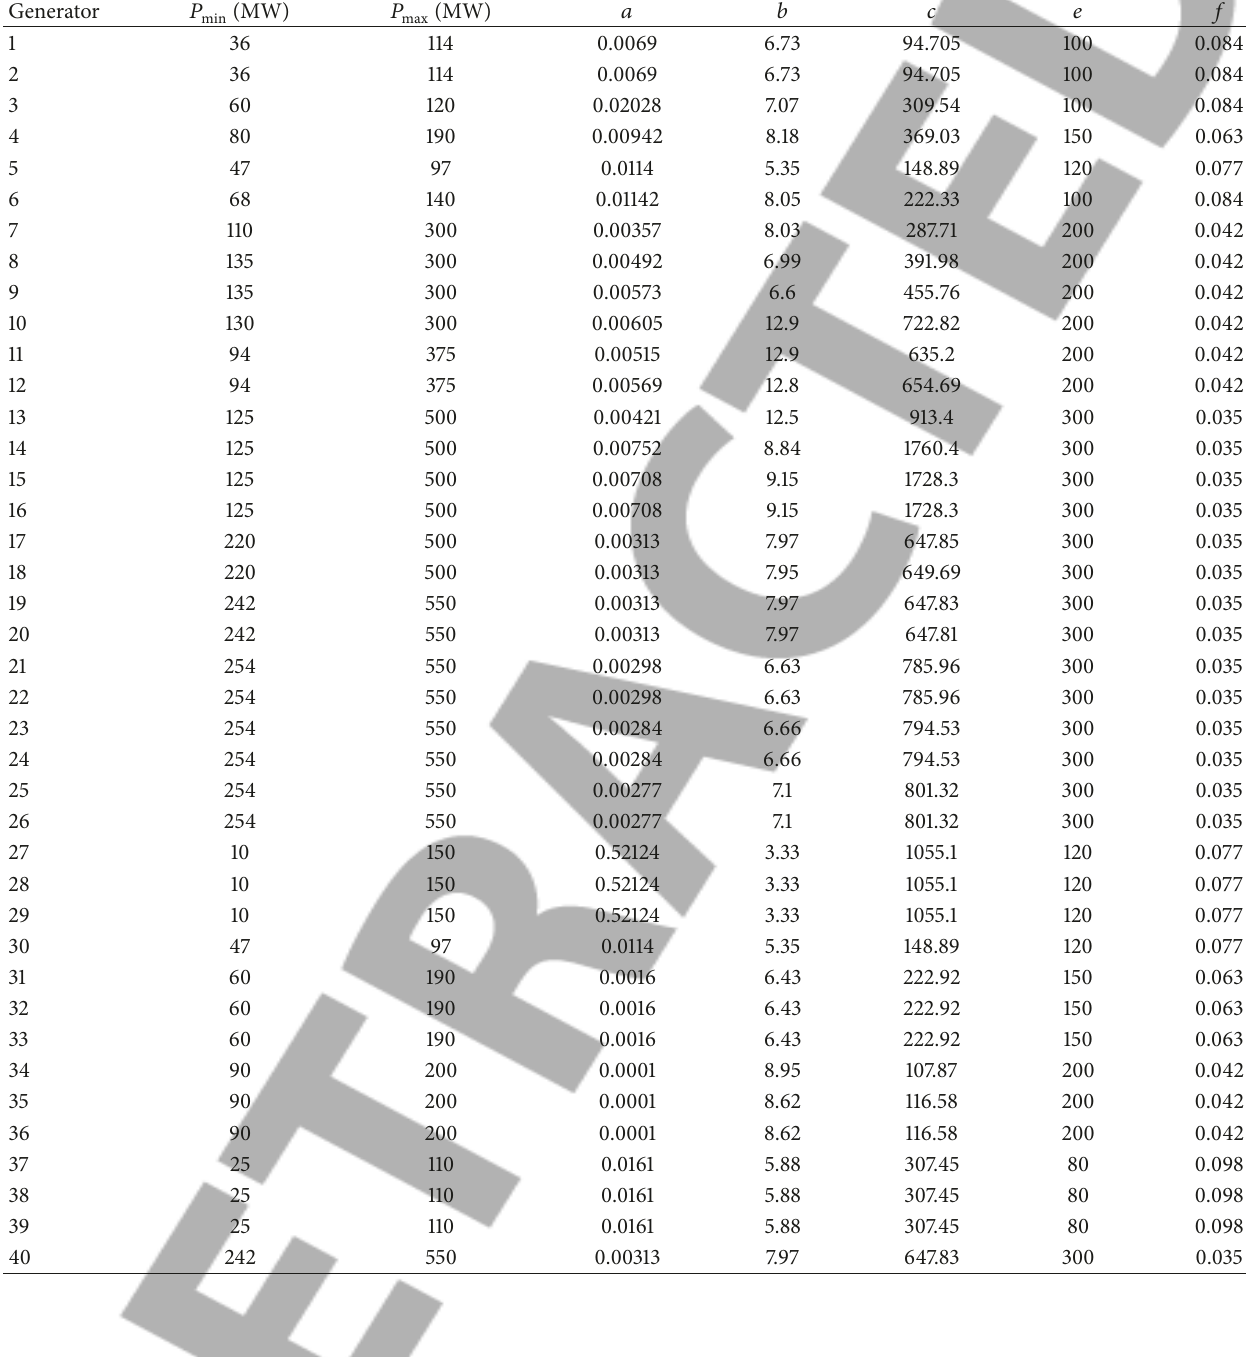
Table 9: Units data for 40 thermal units’